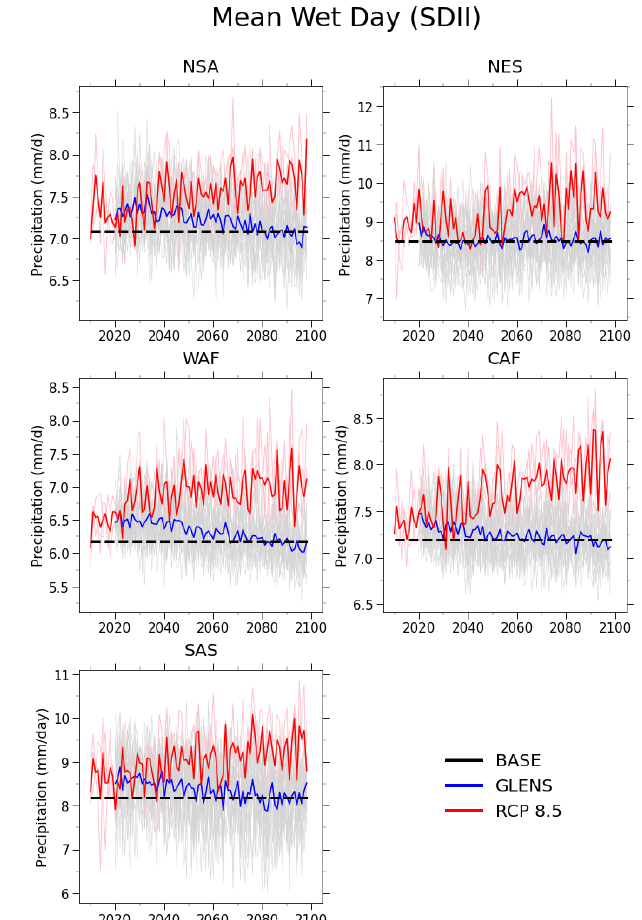
Figure 14. Time series indicating the ensemble ranges of temper- ature indices for BASE (2010–2030; black line), RCP8.5 (2010– 2095; red lines), and GLENS (2020–2095; blue line) for the mean wet day precipitation (SDII) for the same regions as Fig.